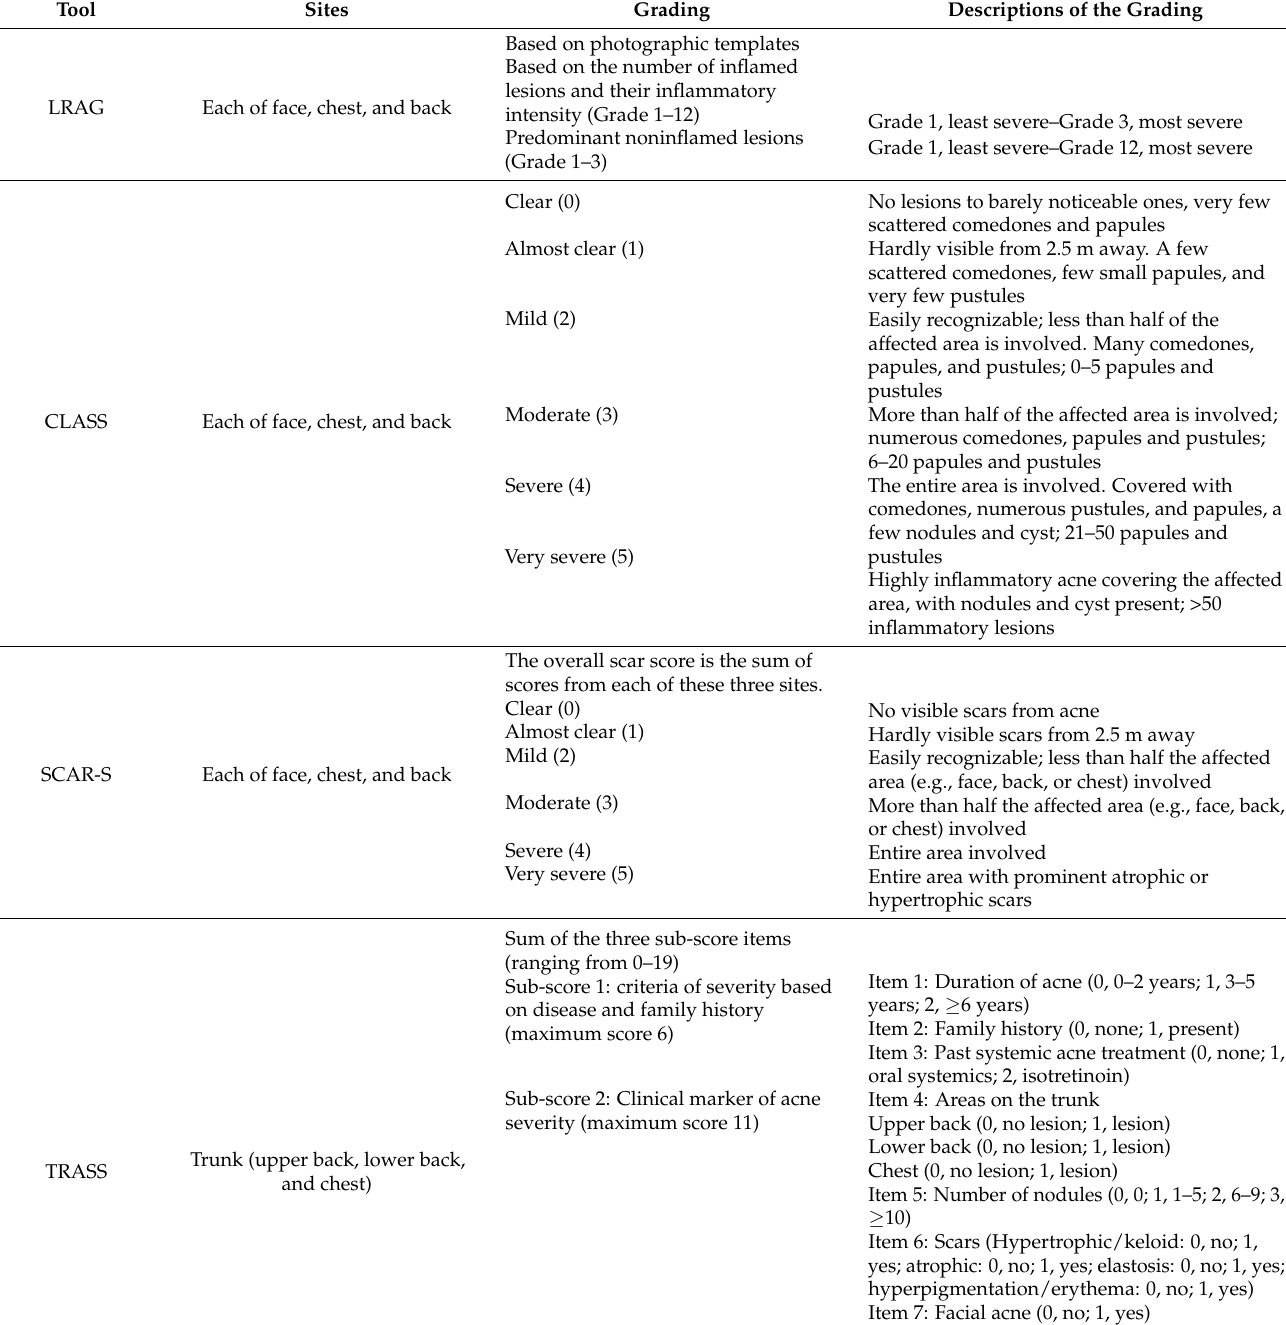
Table 1. Summary of recently developed assessment tool for truncal